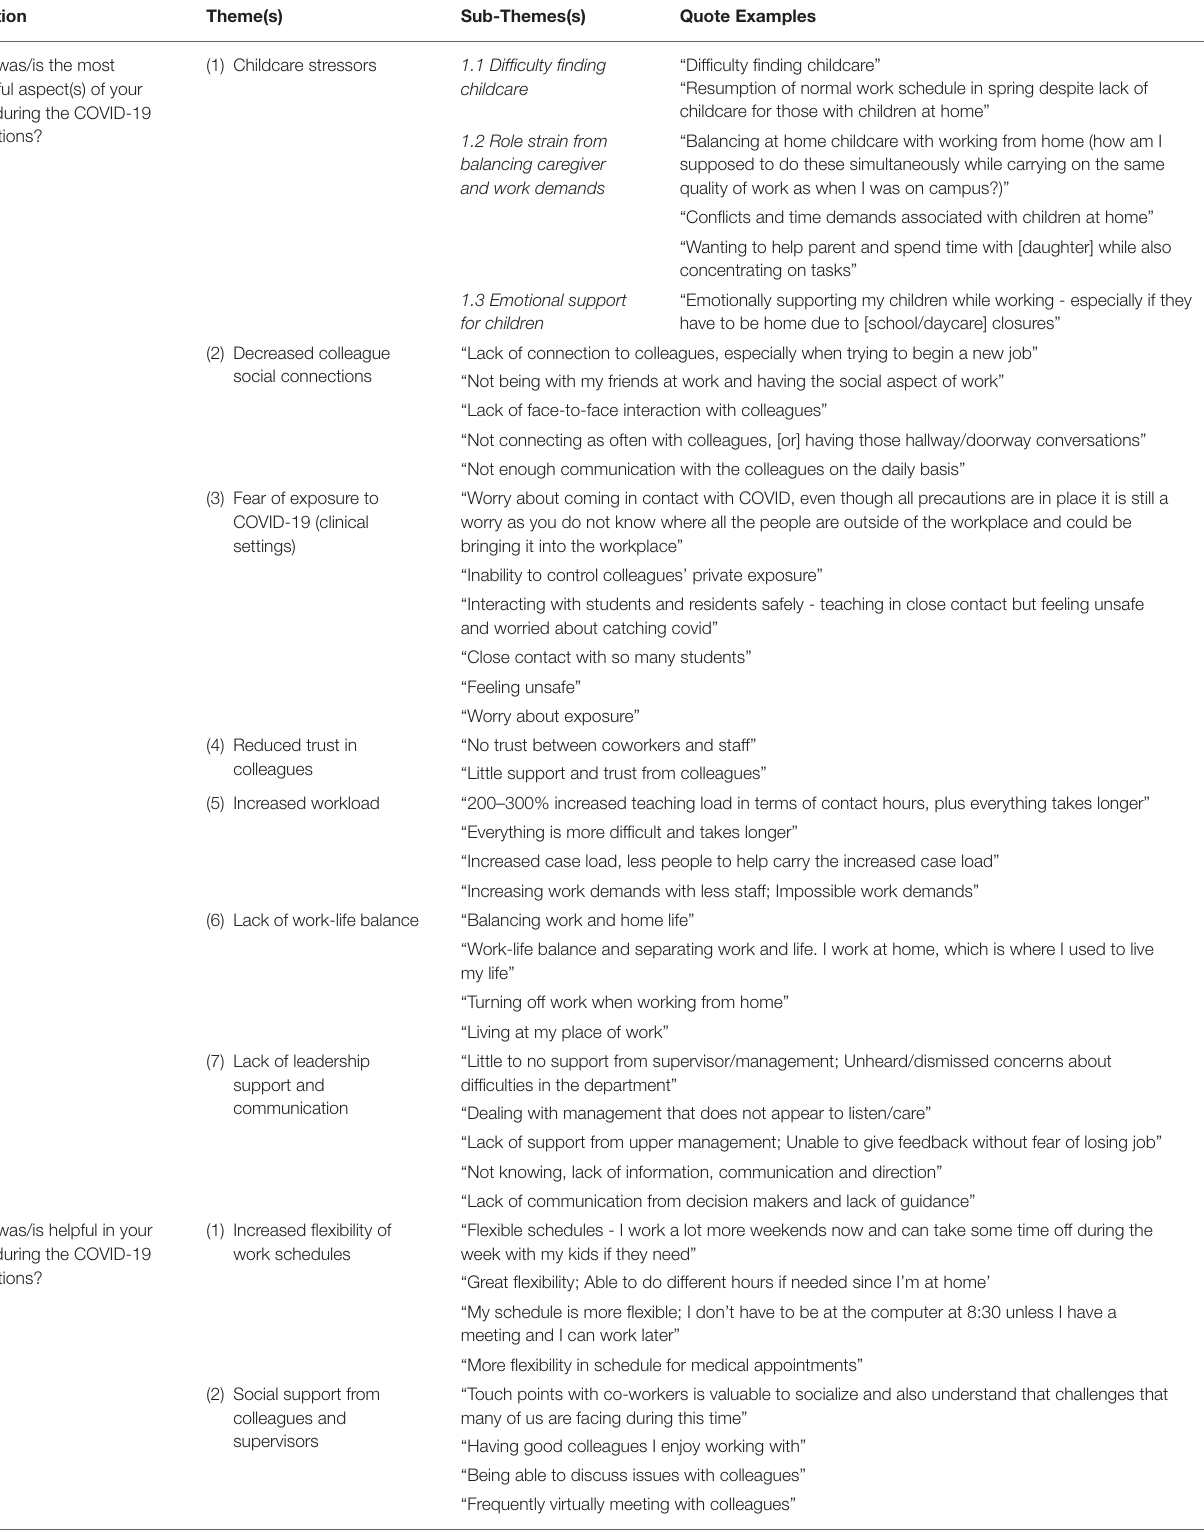
TABLE 7 | Qualitative themes of respondent’s open-text answers regarding workplace stressors, supports, and perceived needs to improve well-being at the OVC, during COVID-19.